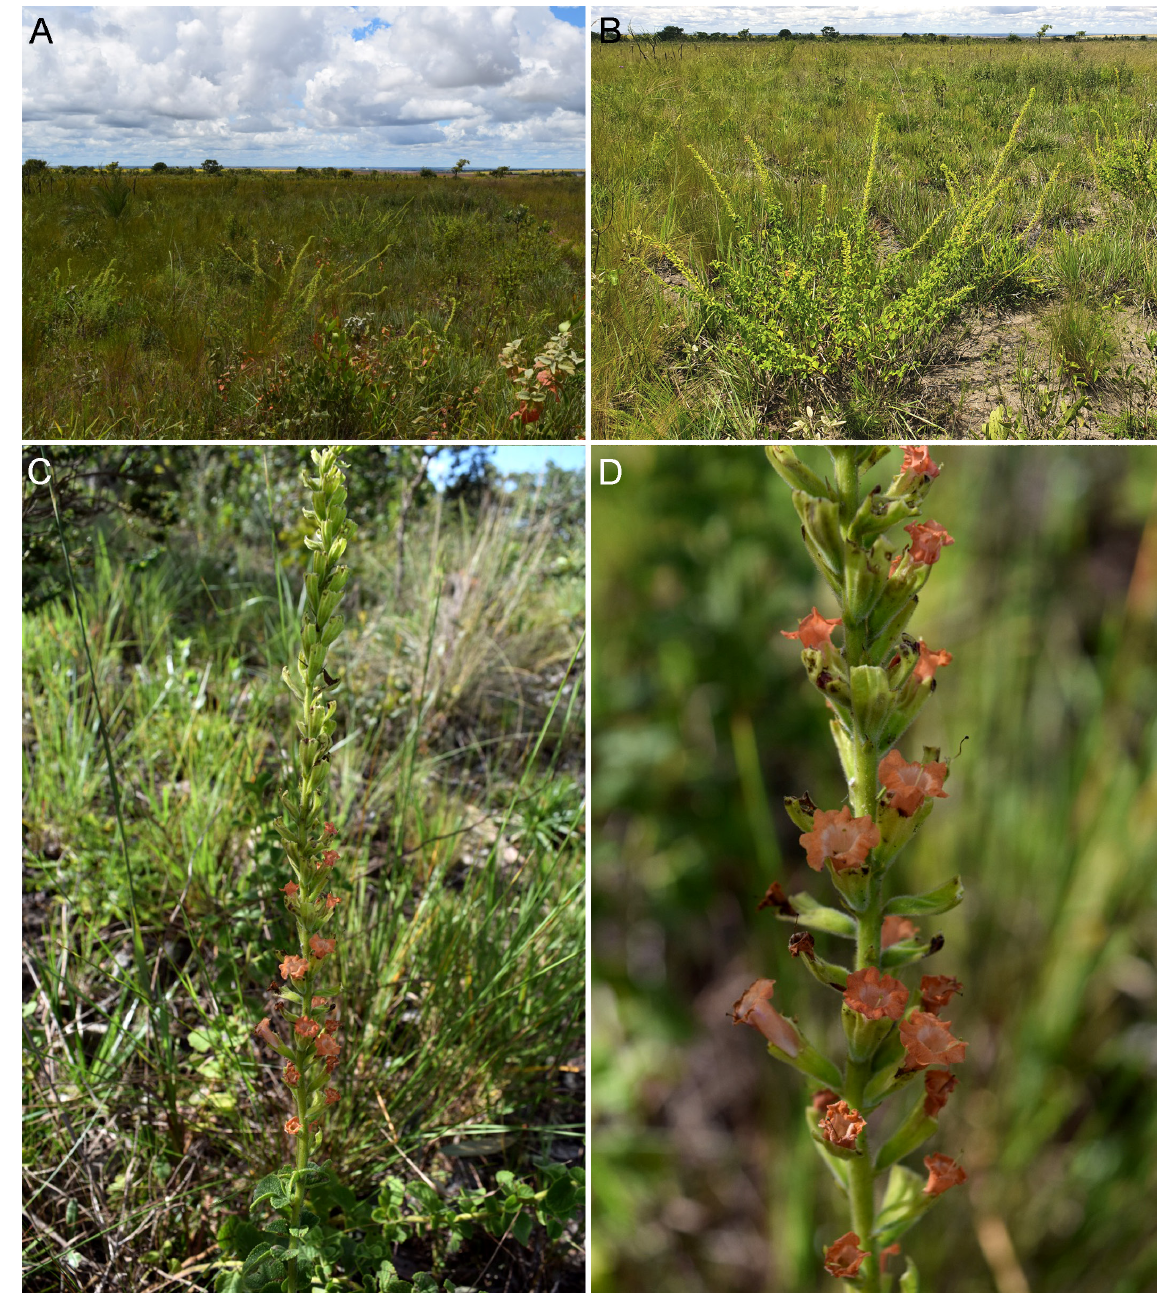
Fig. 11. Stachytarpheta longispicata (Pohl) S.Atkins. A . Habitat. B . Habit. C–D . Individuals showing details of the leaves and inflorescences, highlighting the short pedicels, bracts, calyxes, and corollas. Photos by Marcelo